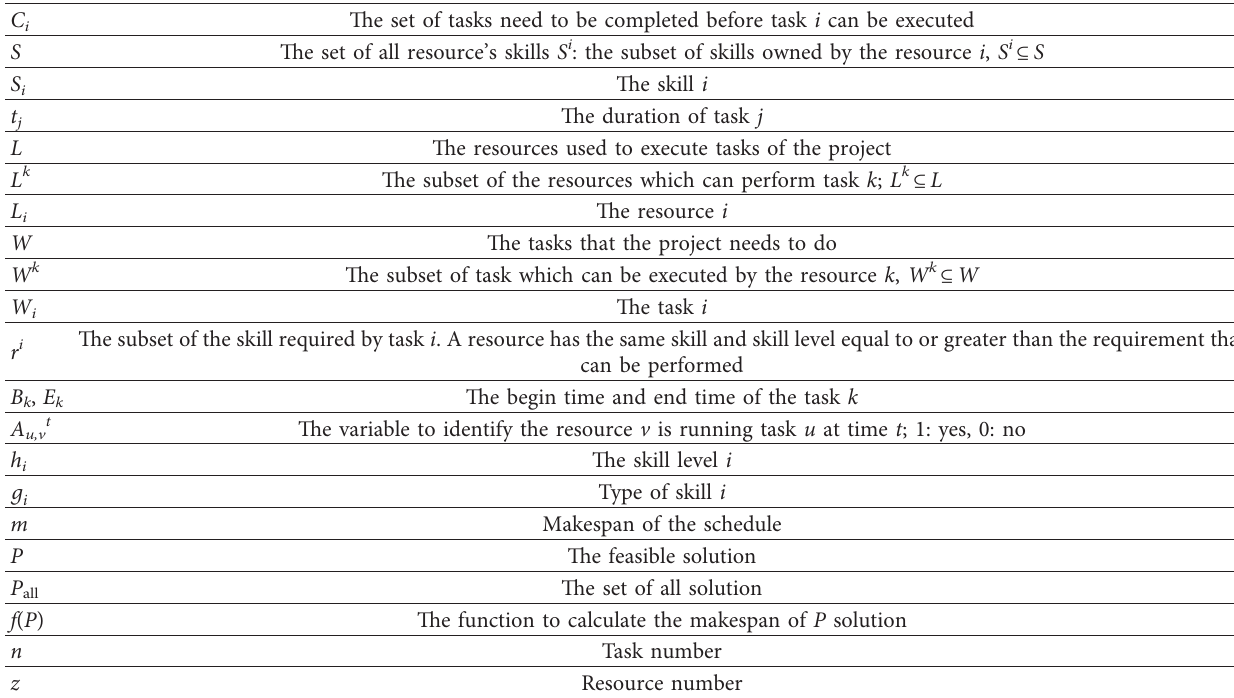
Table 2: The notations.